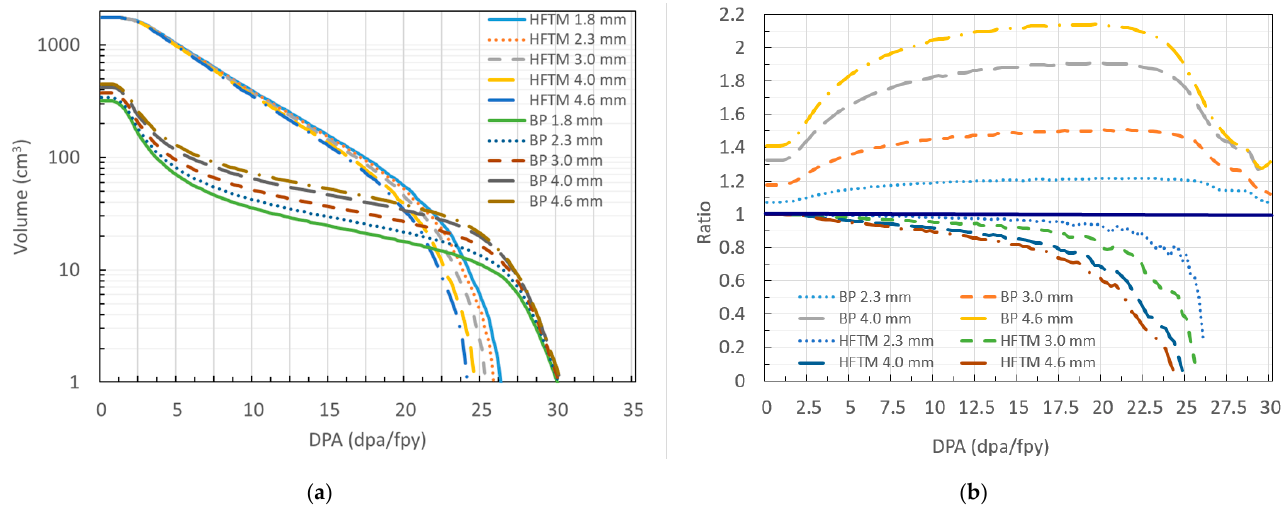
Figure 13. The impact of BP thickness increase on the irradiation volume of BP and HFTM under the “20 × 5” footprint. ( a ) Presents the integral volume over the DPA value and ( b ) provides the ratio of others to the reference case of 1.8 mm-thick BP.